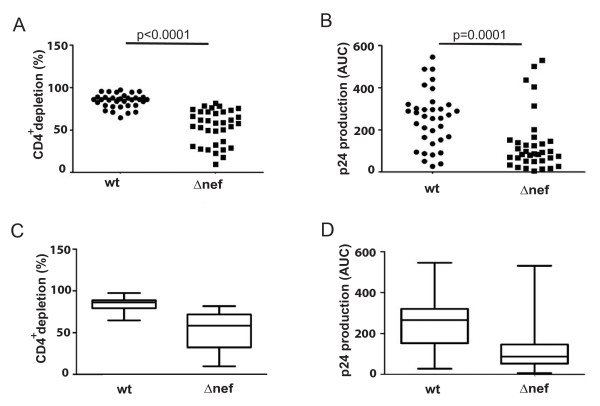
CD4+ T cell depletion and viral replication of wt and Δnef HIV-1 in tonsils from 35 experiments. (A, B) CD4+ T cell depletion (A) and p24 production (B). Each data point represents the mean value of quadruplicate parallel infections. p-values indicate statistical significance by Mann-Whitney-U analysis. (C, D) Boxplot presentation of the data shown in A and B. Boxes indicate the upper and lower quartile (box borders), median (line within the box) and the maxima and minima of each data set (vertical lines).